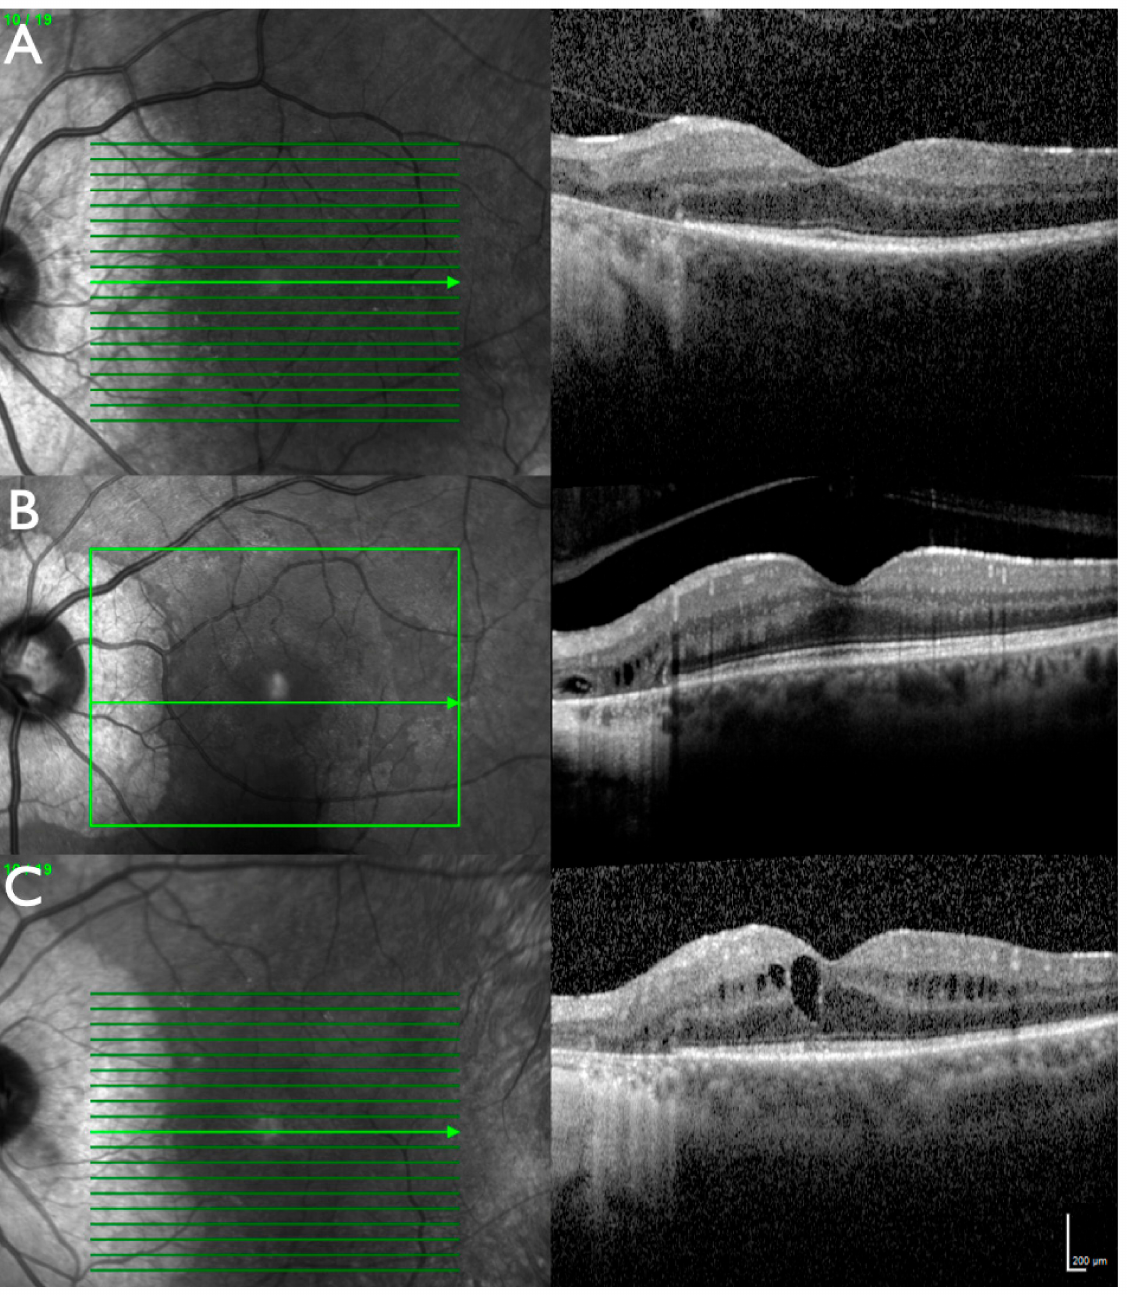
Figure 5. OCT of family ADRP 386 (patient IV:2 ( A ), patient IV:1 ( B ), patient IV:3 ( C )). Peripapillary atrophy is associated with loss of retinal pigment epithelium and outer retinal layers. Those layers appear normal in the areas without atrophy, the border is sharply demarcated. Patient IV:1 shows some intraretinal fluid in the atrophic area, whereas patient IV:3 presents with cystoid macular